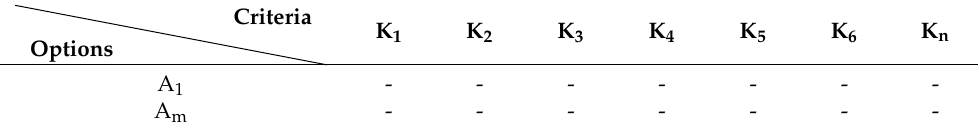
Table 6. Normalized Matrix P .